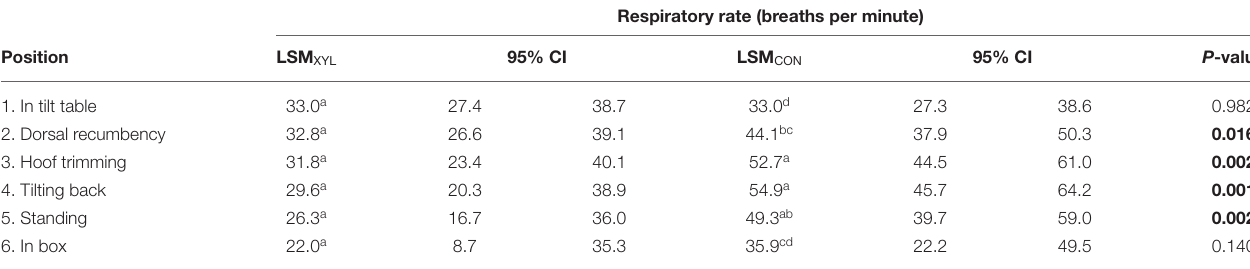
TABLE 3 | Treatment (CON, XYL) comparison at different positions for the respiratory rate.